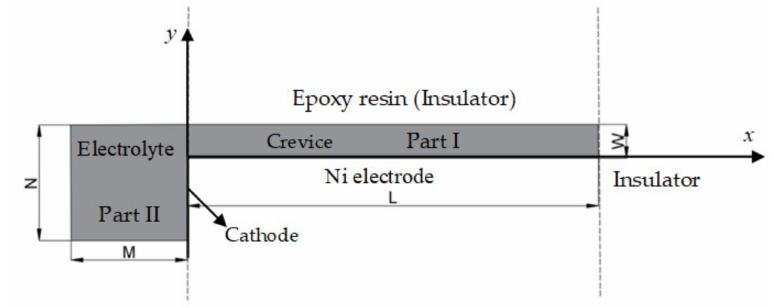
Figure 1. 2-D electrochemical model for corrosion. The gray area is electrolyte. Not to scale.